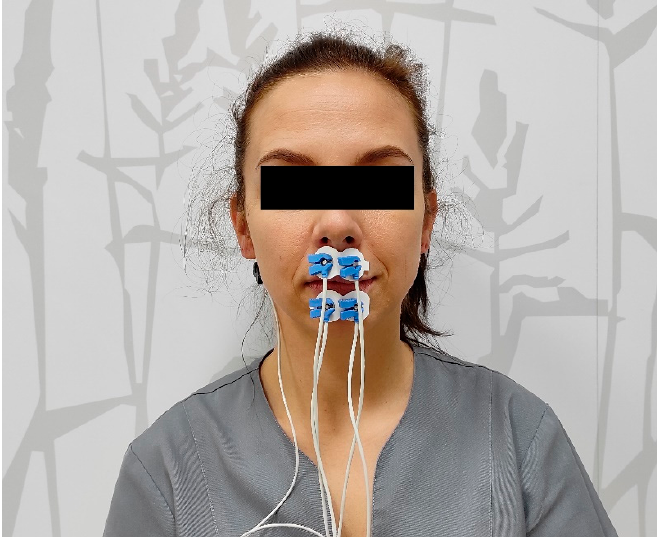
Figure 1. Location of electrodes (Noraxon Dual Electrode, Noraxon, Scottsdale, AZ, USA) during sEMG recordings of the superior orbicularis oris (SOO) and inferior orbicularis oris (IOO) muscles.